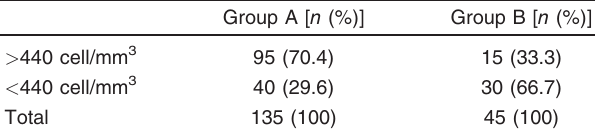
Table 6 Results of sensitivity, specificity, and accuracy among the three types of